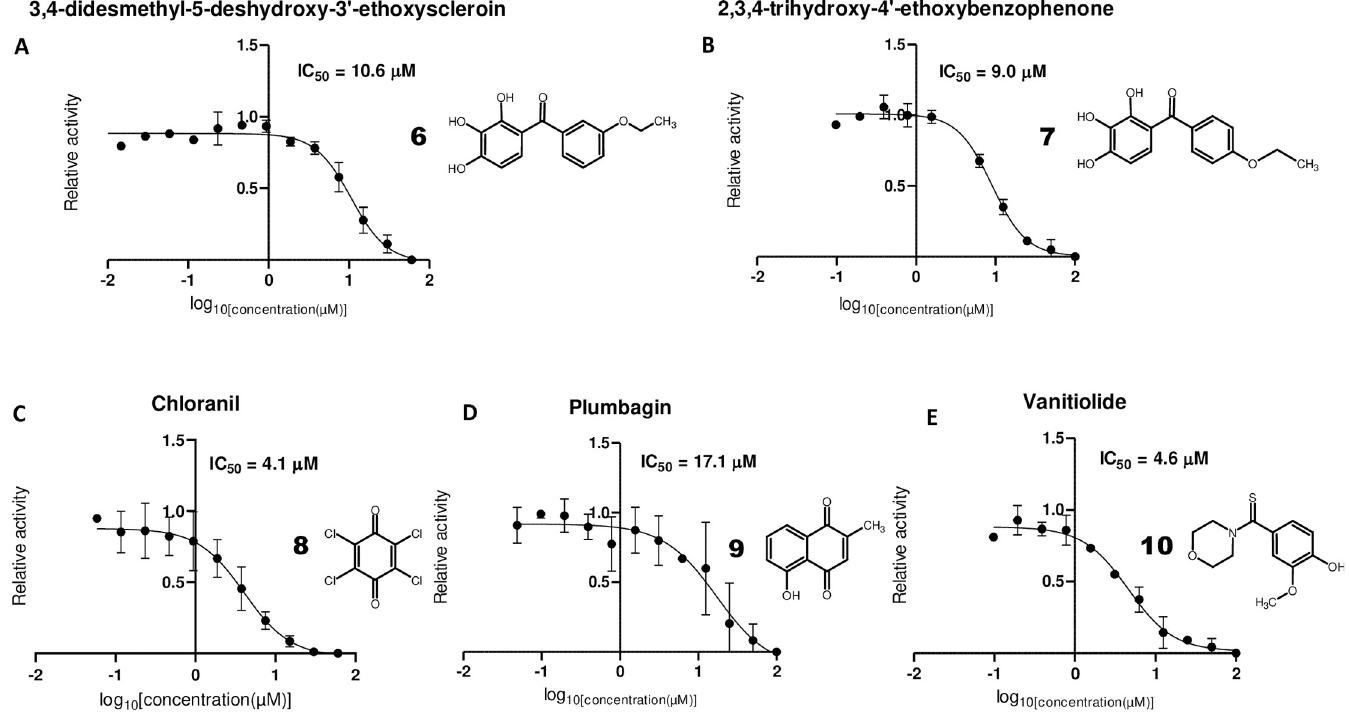
Fig 4. Further effective inhibitors of SARS-CoV-2 M pro . Dose-response curves for (A) 3,4-didesmethyl-5-deshydroxy-3’-ethoxyscleroin, (B) 2,3,4-trihydroxy-4’- ethoxybenzophenone, (C) chloranil, (D) plumbagin and (E) vanitiolide. IC 50 values were determined as stated in Fig 1 .